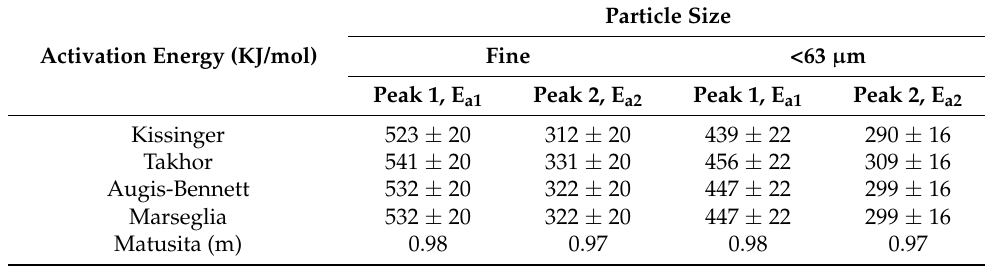
Table 6. Activation energies for 10B(Sr)